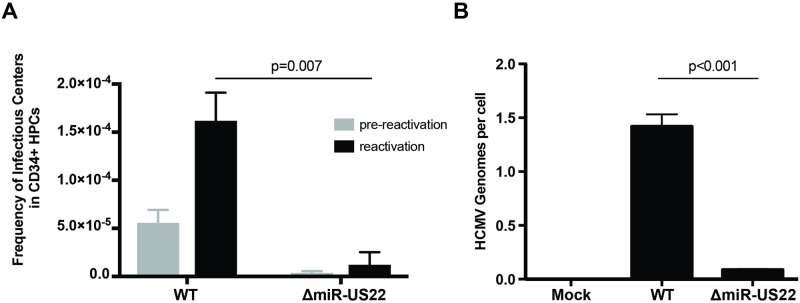
miR-US22 is required for viral reactivation in latently infected CD34+ HPCs.A) CD34+ HPCs were infected with WT TB40E or ΔmiR-US22 TB40E for 48 hours, and FACS-isolated for viable CD34+ GFP+ HPCs. Sorted cells were plated on stromal cell support for 12 days to establish viral latency. Viral reactivation was induced by co-culture on fibroblasts with cytokine stimulation for 21 days, and reactivation was measured by ELDA assay. The pre-reactivation control represents the amount of virus present in cell lysates at the end of latency prior to beginning reactivation. Reactivation data shown are from 2 independent experiments. Significance was calculated using paired t-test. B) CD34+ HPCs were infected and cultured to establish latency as described in A. After 12 days in latency culture (14dpi) DNA was extracted using a two-step TRIZOL method and viral genomes analyzed by qPCR using copies of HCMV UL141 per two copies of human β-globin. Significance was calculated using t-test for three replicate qPCR reactions. Data shown is from one representative experiment out of four independent HPC donors.